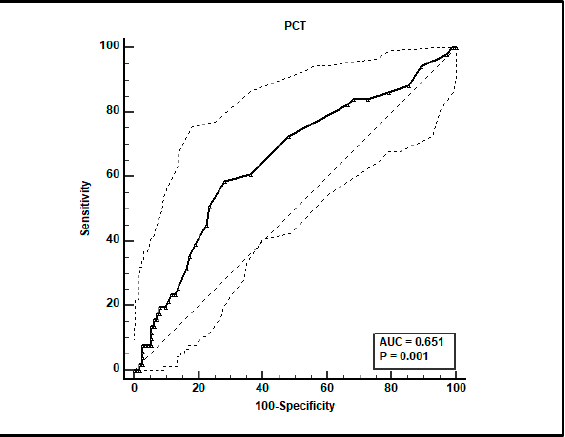
Figure 1. ROC curve analysis for voriconazole C min > 3 mg/L. An optimal cut-off of CRP value > 11.46 mg/dL was found with a sensitivity of 52.2% and specificity of 85.2%. A total of 161 paired voriconazole C min -serum procalcitonin (PCT) determinations